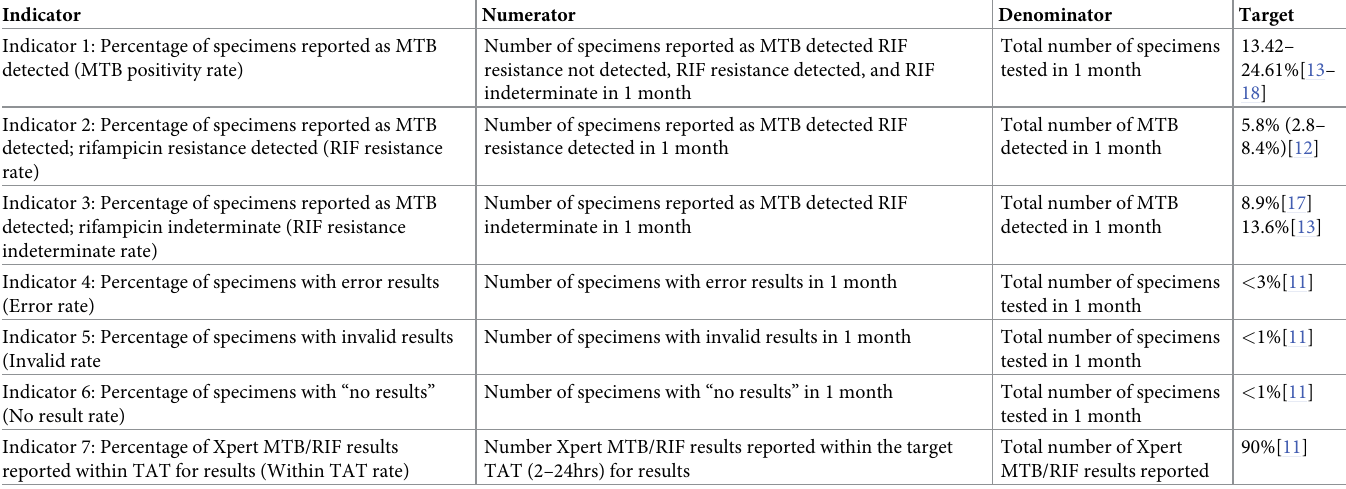
Table 1. Quality indicators implemented to monitor the performance of Xpert MTB/RIF molecular assay in